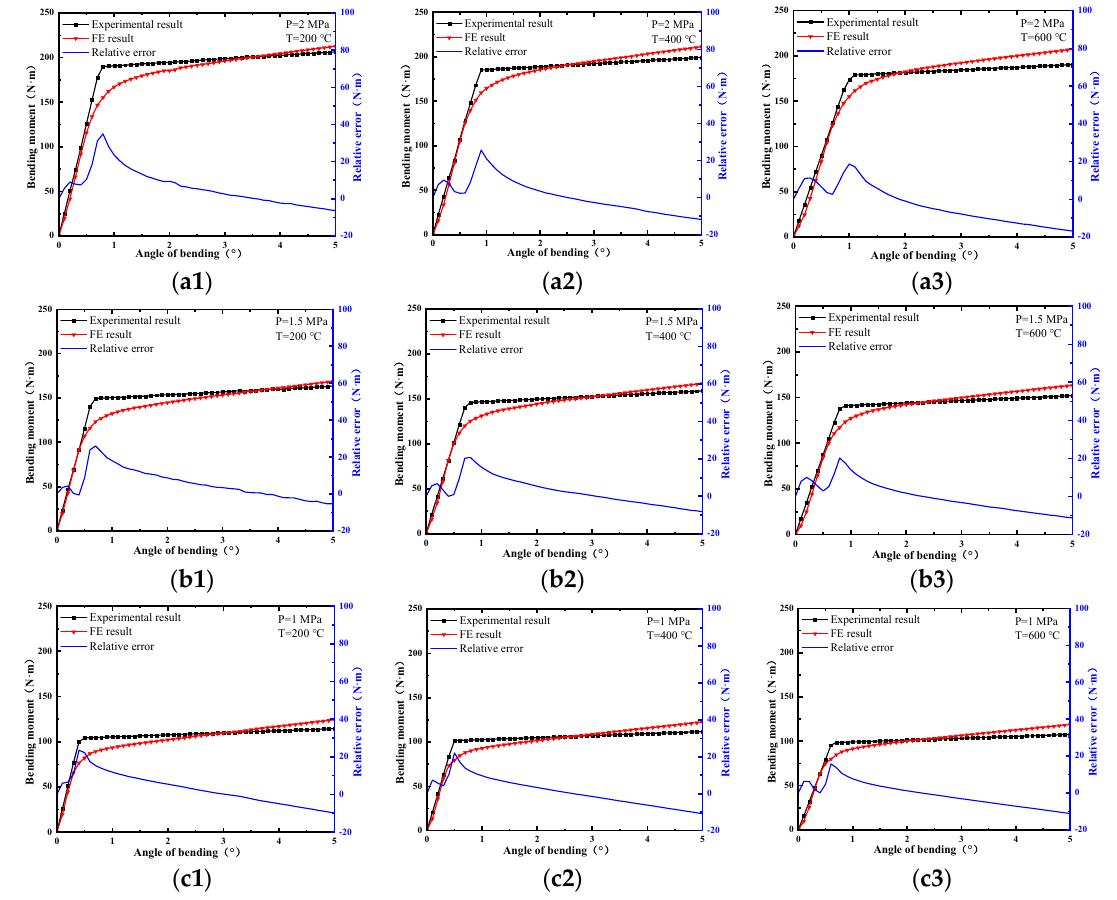
Figure 10. The relative error of experiment results and FE results: ( a1 ) P = 2 MPa, T=200 °C; ( a2 ) P = 2 MPa, T = 400 °C; ( a3 ) P=2 MPa, T=600 °C; ( b1 ) P=1.5 MPa, T = 200 °C; ( b2 ) P=1.5 MPa, T = 400 °C; ( a2 ) P = 2 MPa, T = 400 ◦ C; ( a3 ) P=2 MPa, T=600 ◦ C; ( b1 ) P=1.5 MPa, T = 200 ◦ C; ( b2 ) P=1.5 MPa, (b3) P = 1.5 MPa, T = 600 °C; ( c1 ) P=1 MPa, T = 200 °C; ( c2 ) P=1 MPa, T = 400 °C; ( c3 ) P=1 MPa, T = T = 400 ◦ C; (b3) P = 1.5 MPa, T = 600 ◦ C; ( c1 ) P=1 MPa, T = 200 ◦ C; ( c2 ) P=1 MPa, T = 400 ◦ C; ( c3 ) P=1 600 °C. MPa, T = 600 ◦